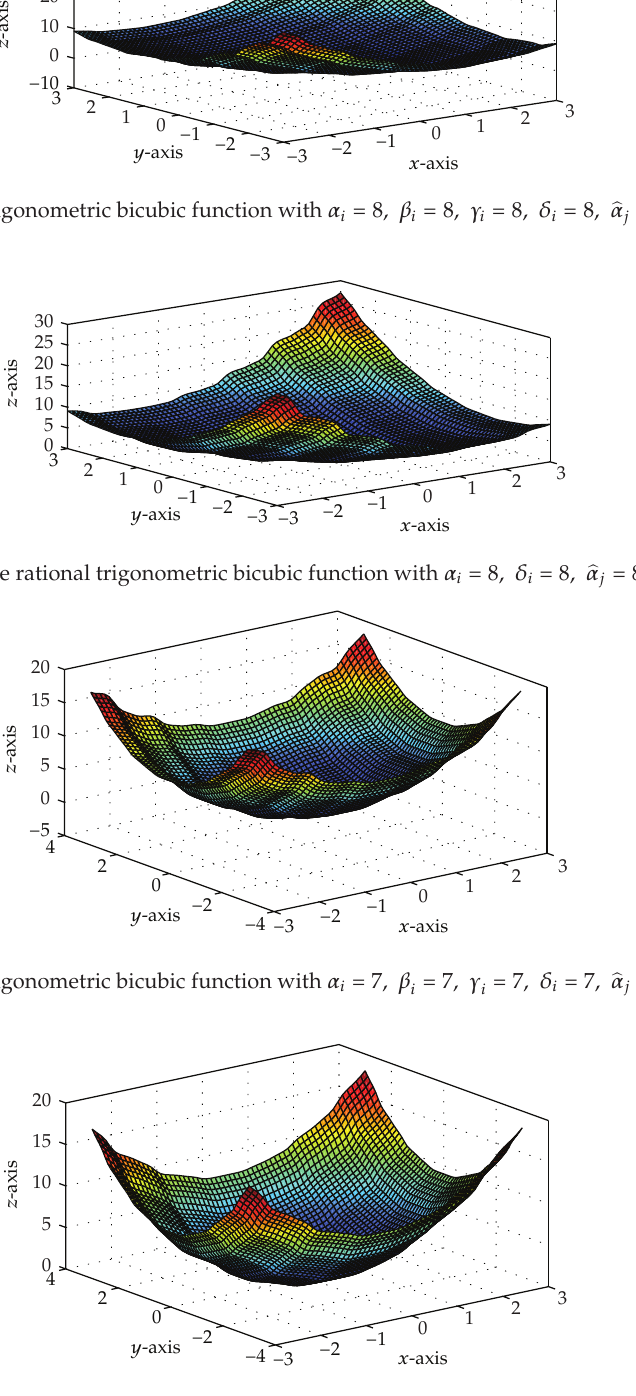
(cid:28) δ j (cid:8)